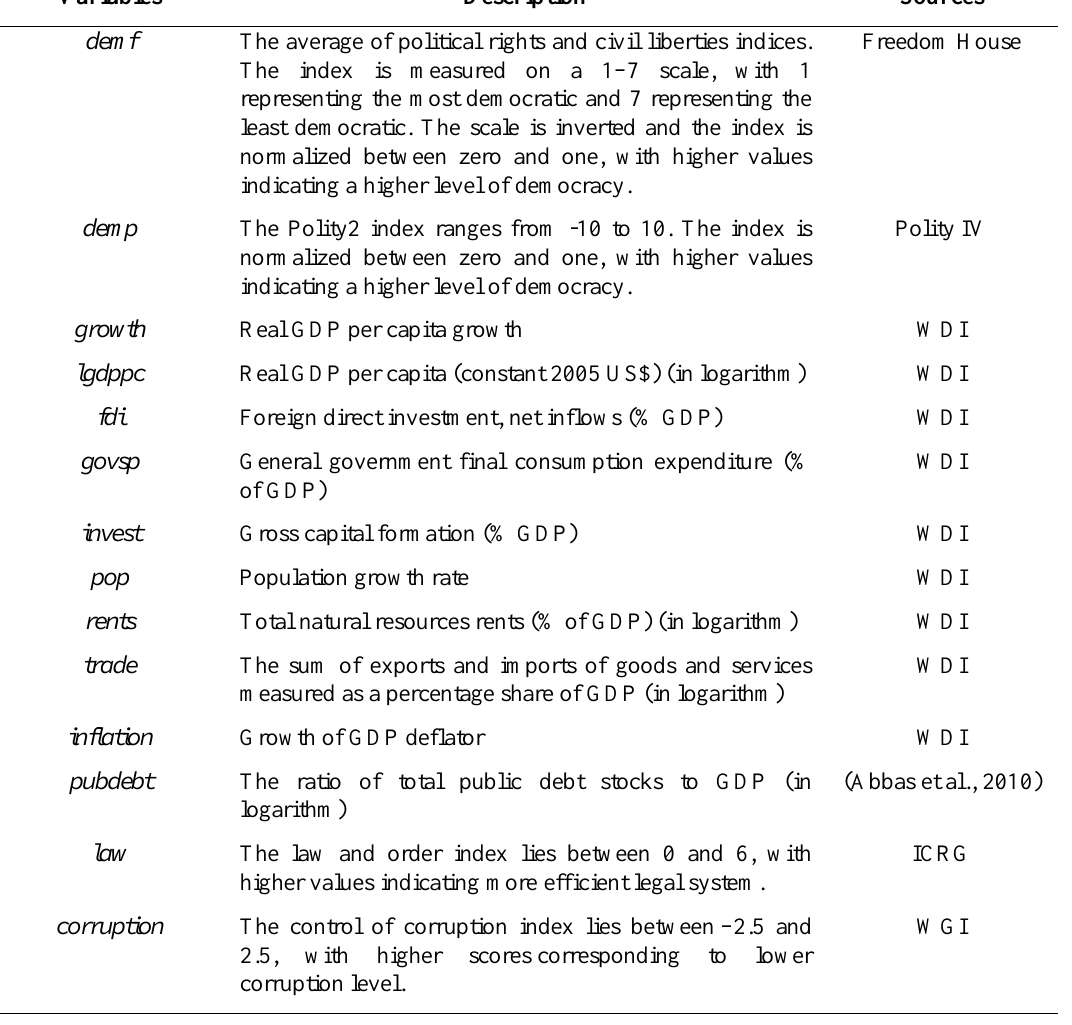
Table A.1: Variables description and data Sources Variables